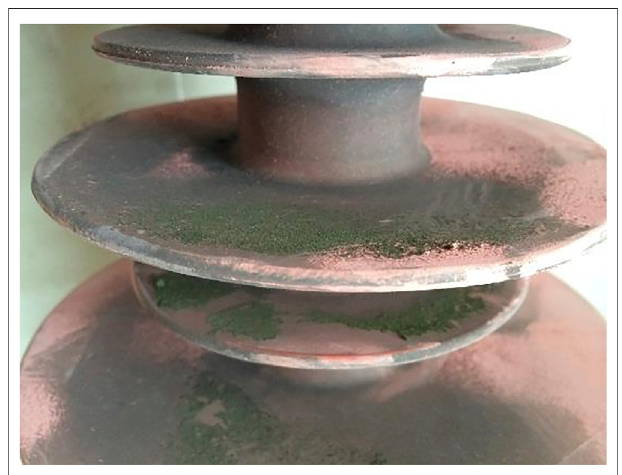
FIGURE 2 | Morphology of fungi-fouled